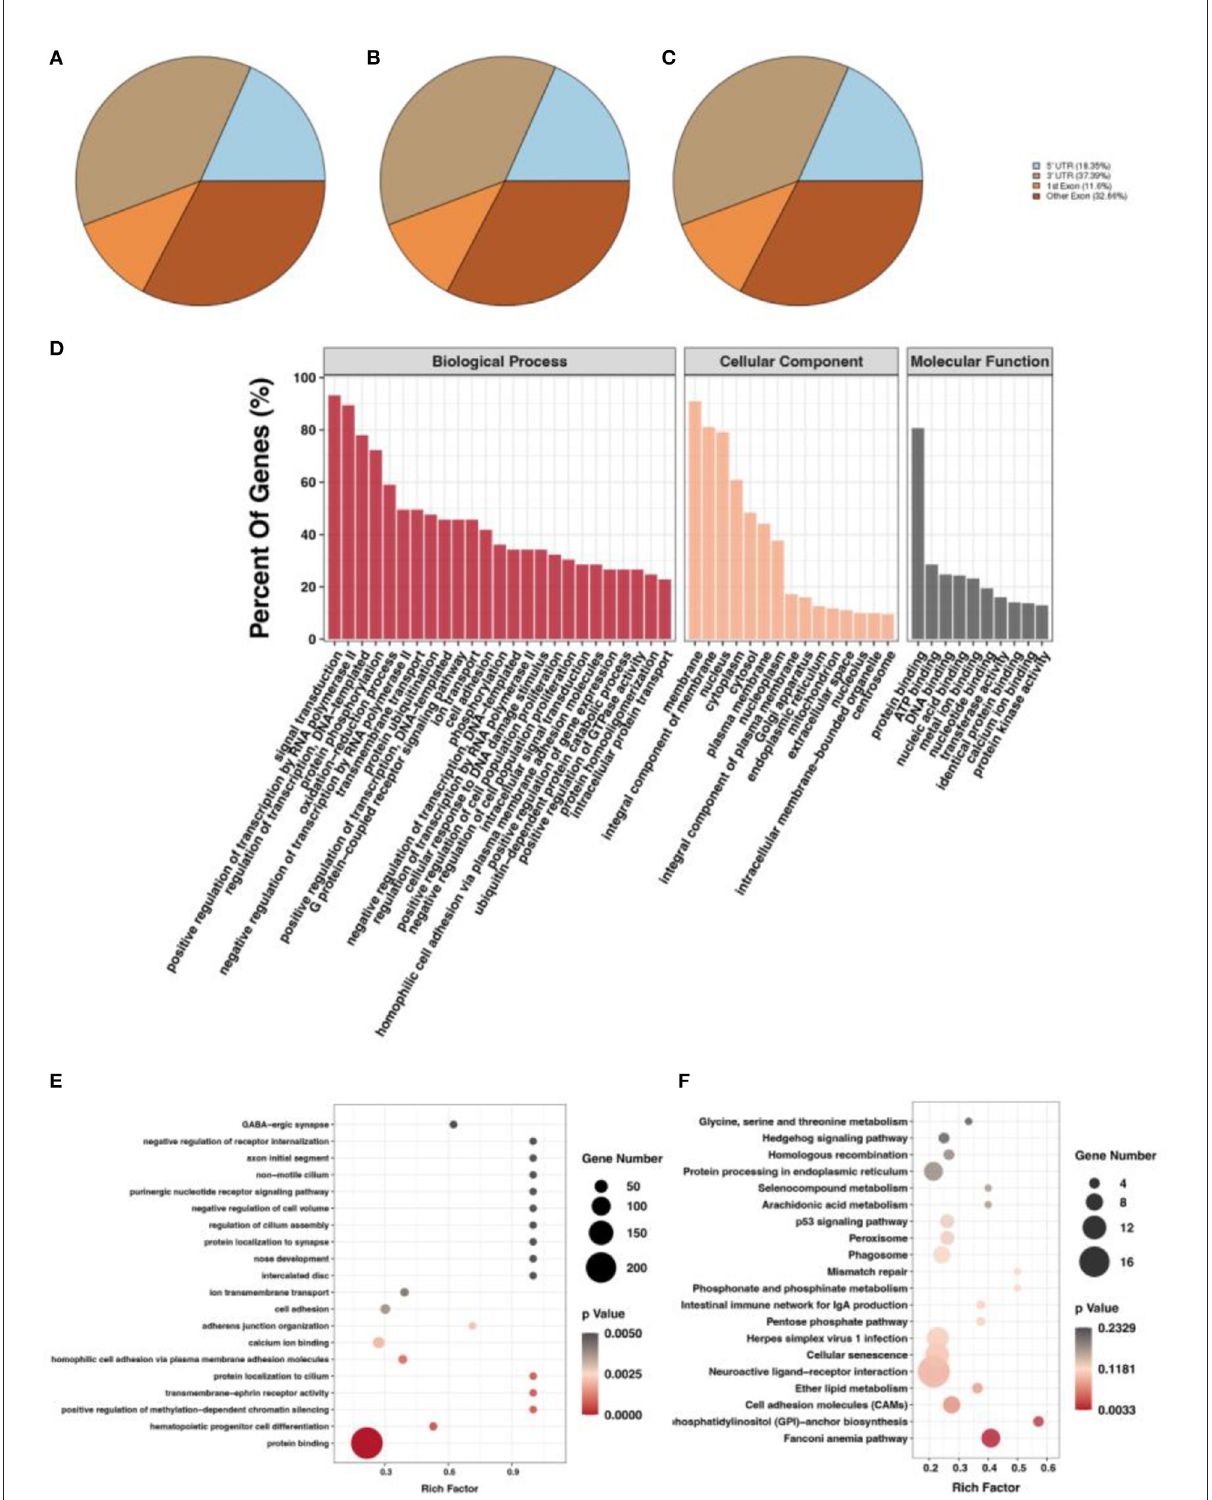
FIGURE2 m6A methylation peak screening and differential m6A peak analysis. (A) m6A methylation peaks at E10. (B) m6A methylation peaks at E19. (C) Overlapped m6A methylation peaks between E10 and E19. (D) GO enrichment barplot of DMGs. (E) GO enrichment scatterplot of DMGs. (F) KEGG enrichment scatterplot of